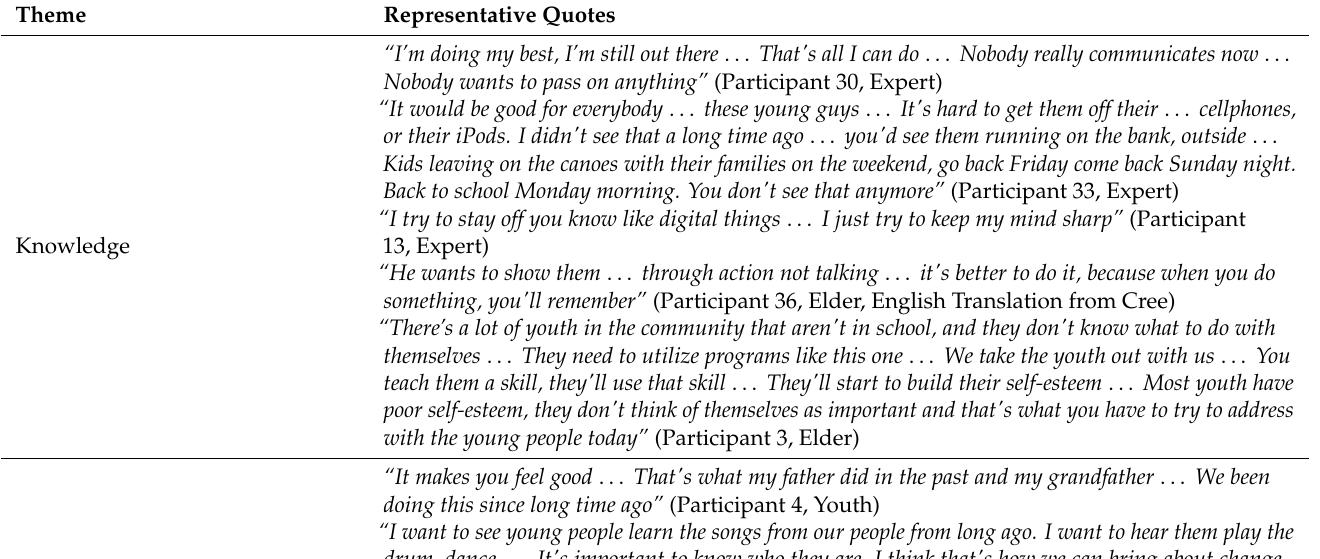
Table A1. The following quotations for the summer goose harvest were not included in the primary text; however, they provide additional insight into the topic